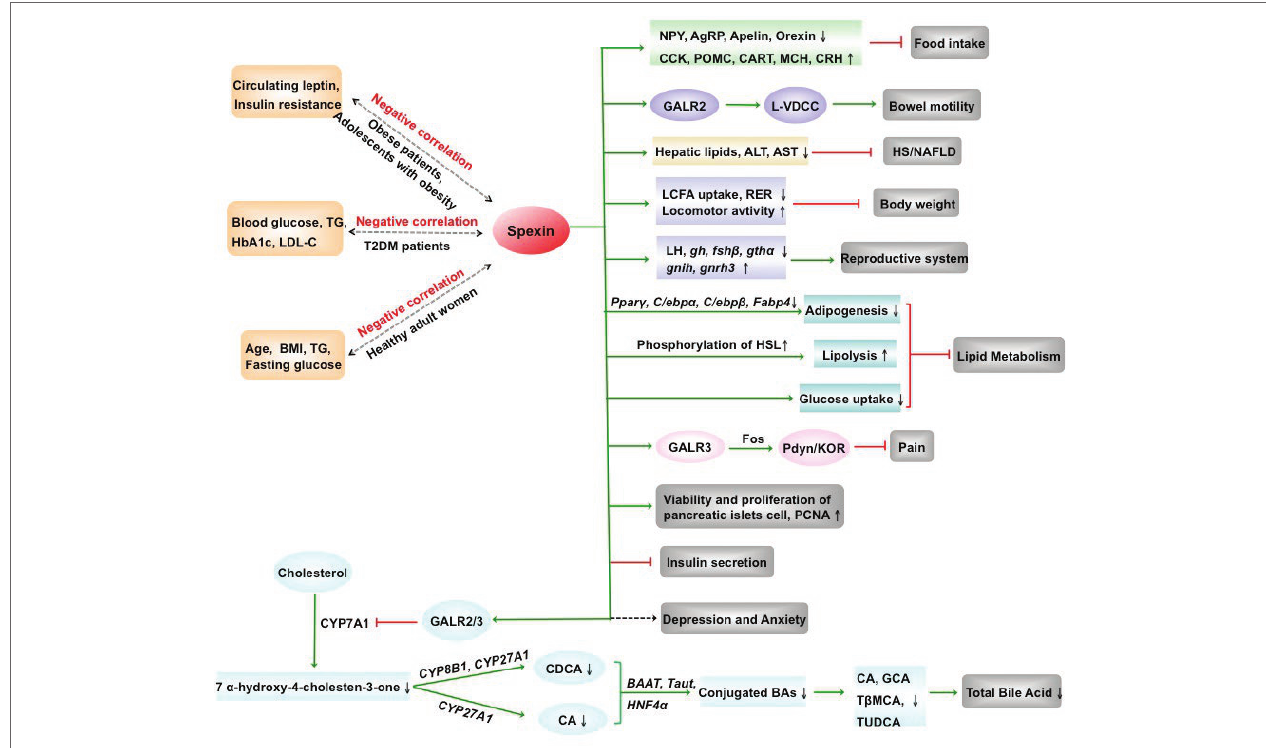
FIGURE 2 | The physiological and pathophysiological effects of spexin. AgRP, agouti gene-related protein; ALT, alanine transaminase; AST, aspartate aminotransferase; BAAT, bile acid CoA: amino acid N-acyltransferase; BAs, bile acids; BMI, body mass index; CA, cholic acid; CART, cocaine-amphetamine regulated transcript; CCK, cholecystokinin; CDCA, chenodeoxycholate; CRH, corticotropin-releasing hormone; CYP27A1, sterol 27-hydroxylase; CYP7A1, cholesterol 7 α -hydroxylase 1; CYP8B1, sterol 12 α -hydroxylase; fsh β , follicle-stimulating hormone β ; GalR2, galanin receptor 2; GalR3, galanin receptor 3; GCA, glycocholate; gh, growth hormone; gnih, gonadotropin inhibitory hormone; gnrh3, gonadotropin-releasing hormone 3; gth α , gonadotropin hormone α ; HbA1c, hemoglobin A1c; HNF4 α , hepatocyte nuclear factor 4 alpha; HS/NAFLD, hepatic steatosis/nonalcoholic fatty liver disease; KOR, κ -opioid receptor; LCFA, long-chain fatty acid; LDL-C, low-density lipoprotein-cholesterol; LH, luteinizing hormone; L-VDCC, L-type voltage-dependent calcium channel; MCH, melanin-concentrating hormone; NPY, neuropeptides Y; PCNA, proliferating cell nuclear antigen; Pdyn, prodynorphin; POMC, proopiomelanocortin; RER, respiratory exchange ratio; T2DM, type 2 diabetes mellitus; T β -MCA, tauro- β -muricholate; taut, taurine transporter gene; TG, triglyceride; TUDCA, tauroursodeoxycholate; ↑ , increase; ↓ , decrease; green arrow, promotion; red arrow, inhibition. (Partial figure originated from Lin et al.,